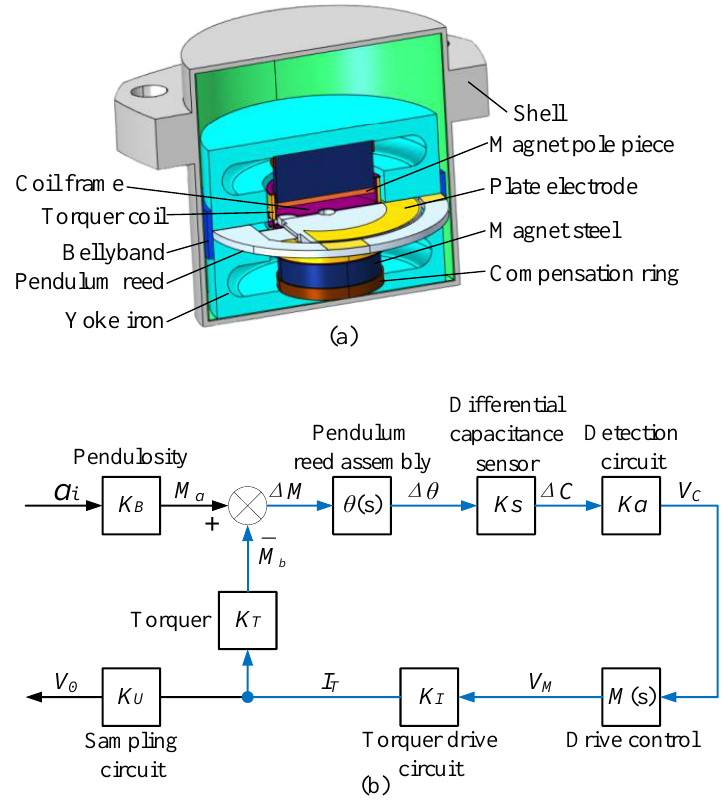
Figure 1. ( a ) Structure of QFA; ( b ) Closed-loop system structure of QFA. In the QFA, the shell, yoke iron, torquer coil, differential capacitor plate, and other components are made of metal materials. These components are independent of each other and do not make contact with each other. When the accelerometer works, there is a potential difference in electricity between different components, which forms the dis- tributed capacitance shown in Figure 2a. C d 1 , C d 2 , and C d 3 are the distributed capacitances between the torquer coil and the plates of the differential capacitor; C bb is the distributed capacitance between the top and bottom plates of the differential capacitor; C e 1 , C e 2 , and C e 3 are the distributed capacitances between the three plates of differential capacitance and the accelerometer shell; and C e 4 is the distributed capacitance between the accelerometer shell and the torquer coil. The distributed capacitance couples the torquer drive current I T to the differential capacitance detection process to form the detection noise V n . Based on this, the equivalent circuit model of electric field coupling detection noise inside the accelerometer is established, as shown in Figure 2b. The controlled current source I T is the current output of the torquer drive circuit; L T and R T are the resistance and inductance of the torquer coil, respectively; and R CS is the current sampling